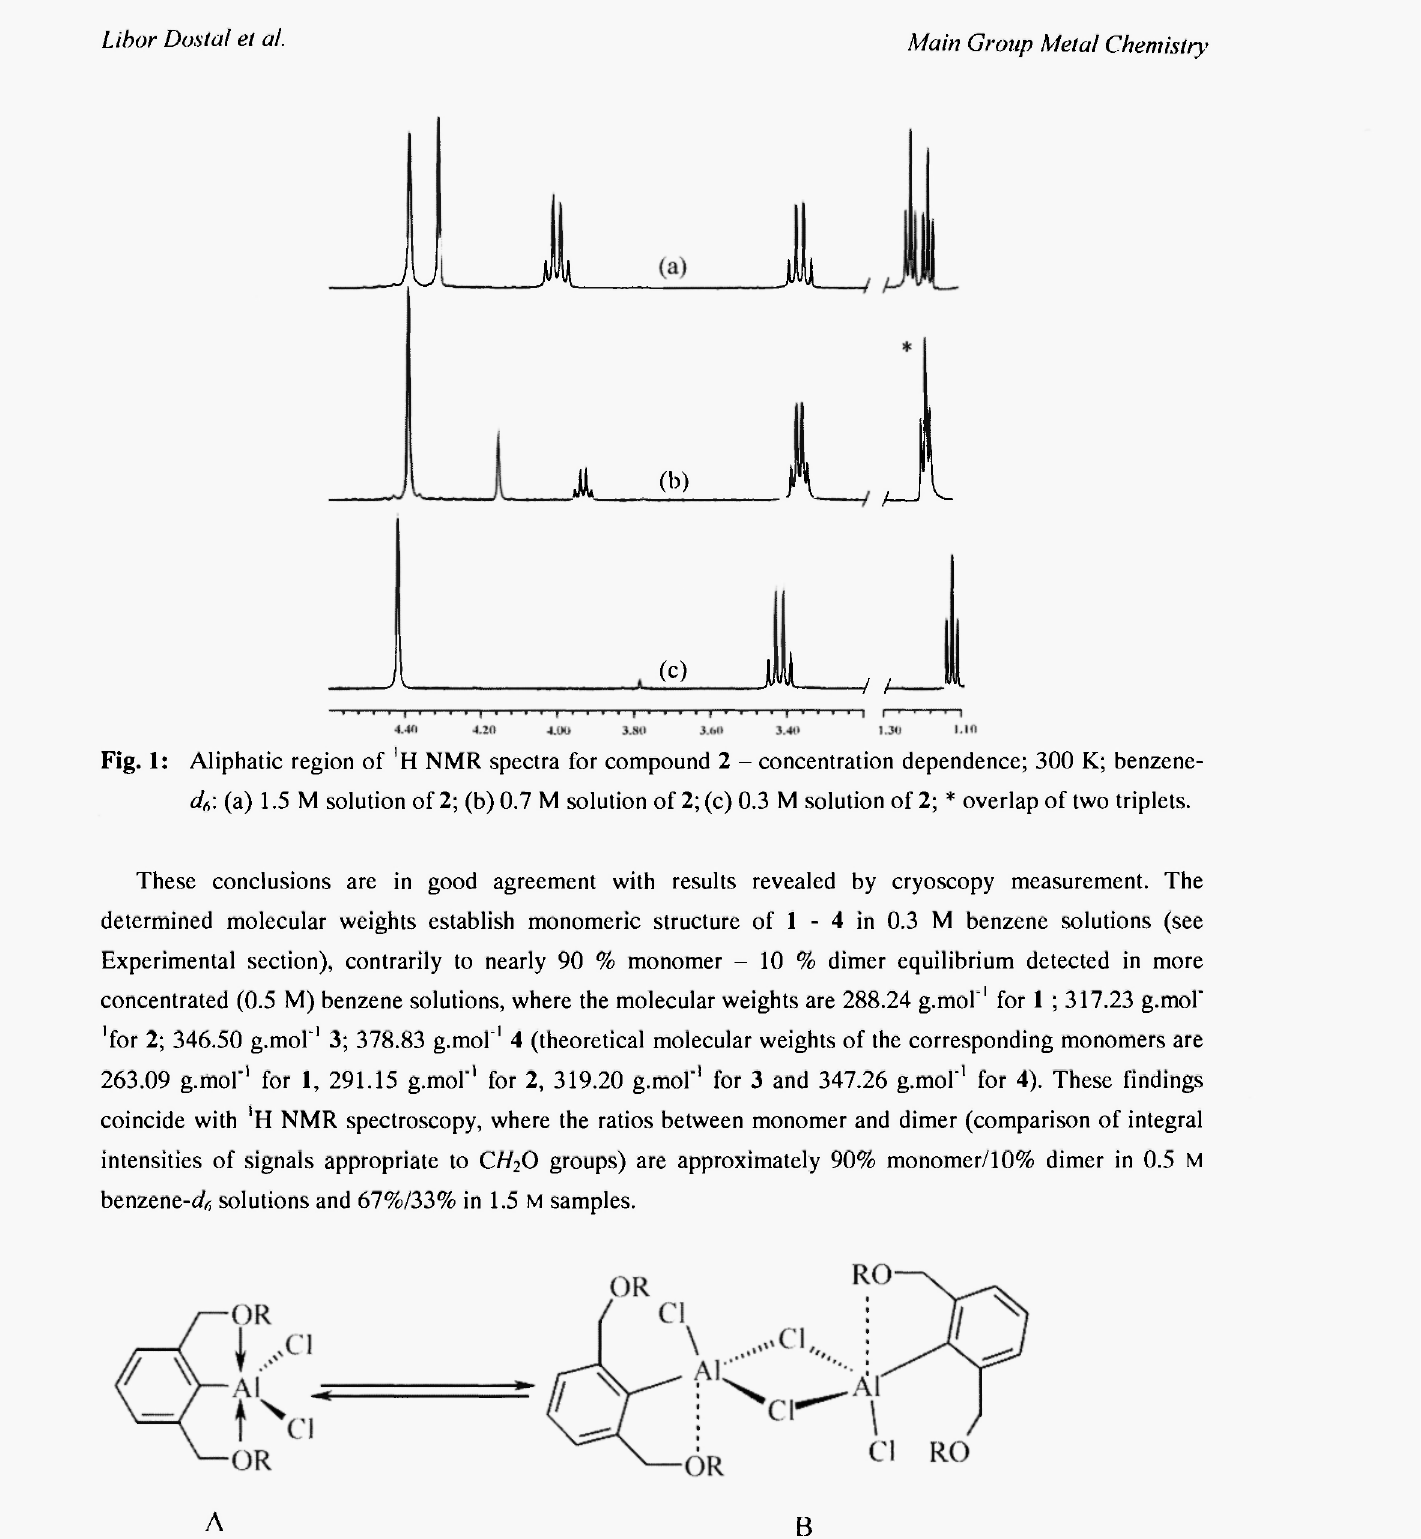
Fig. 2: Proposed monomer - dimer equilibrium in high concentrated solutions; A monomeric structure, Β proposed